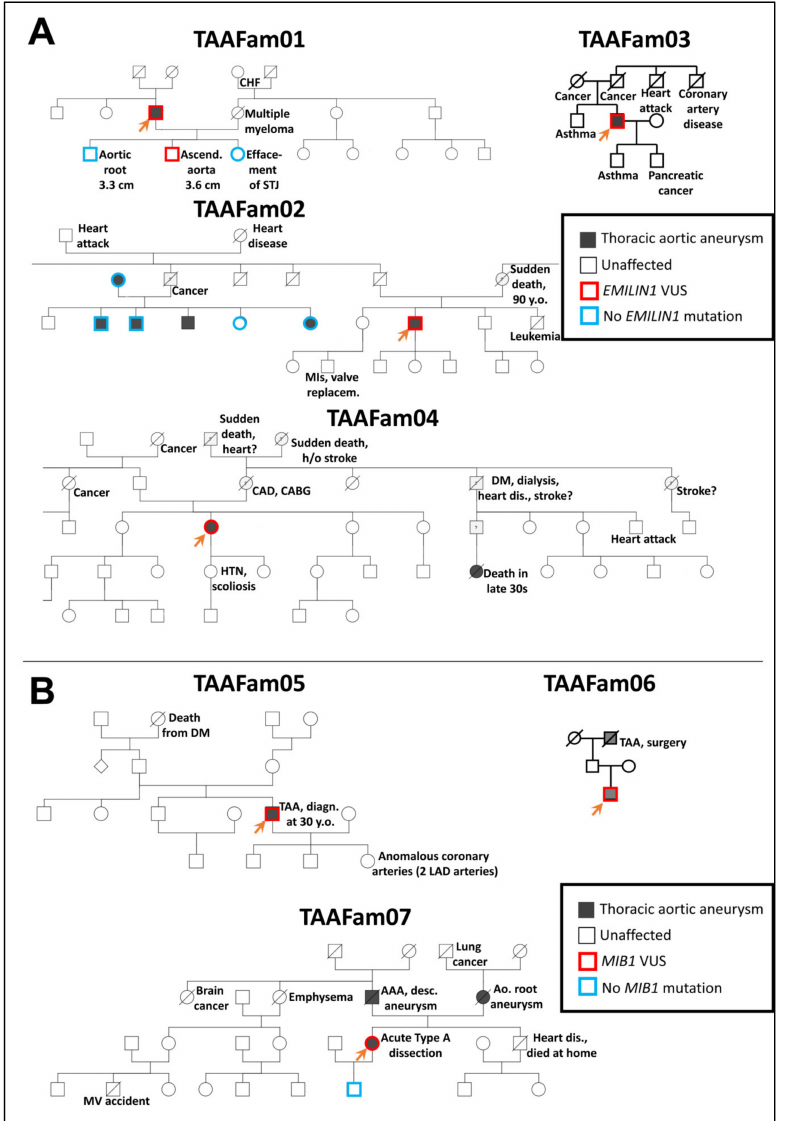
Figure 2. Pedigrees of EMILIN1 (Panel A ) and MIB1 (Panel B ) families with thoracic aortic disease tested as part of routine clinical genetic testing at the Yale Aortic Institute. For testing EMILIN1 variants in the zebrafish model, missense variants identified in TAAFam02 and TAAFam03 were used (p.E170G and p.T904S, respectively). For testing MIB1 variants in the zebrafish model, nonsense vari- ants identified in TAAFam05, TAAFam06, TAAFam07 were used (p.R906X seen both in TAAFam05 and TAAFam06 and p. G596X for TAAFam07). The index patients (labeled with an arrow) underwent exome sequencing, while other family members underwent single-site Sanger